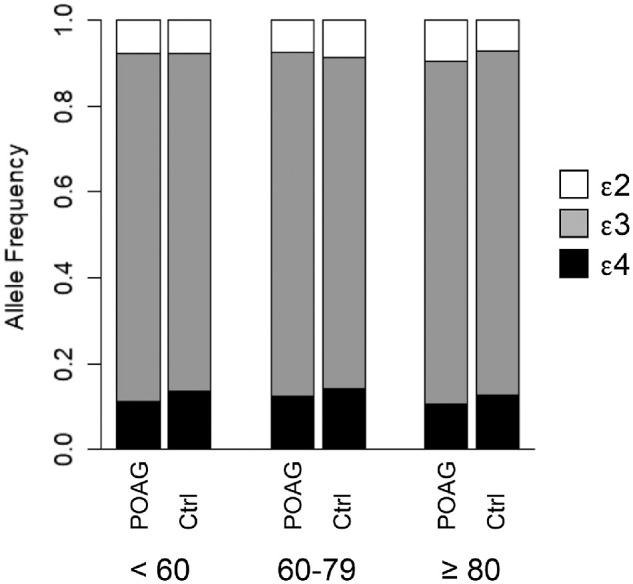
Distribution of APOE alleles according to age. Allele frequencies were not significantly different across age groups in either cases or controls (P > 0.2 from each of six pairwise comparisons).